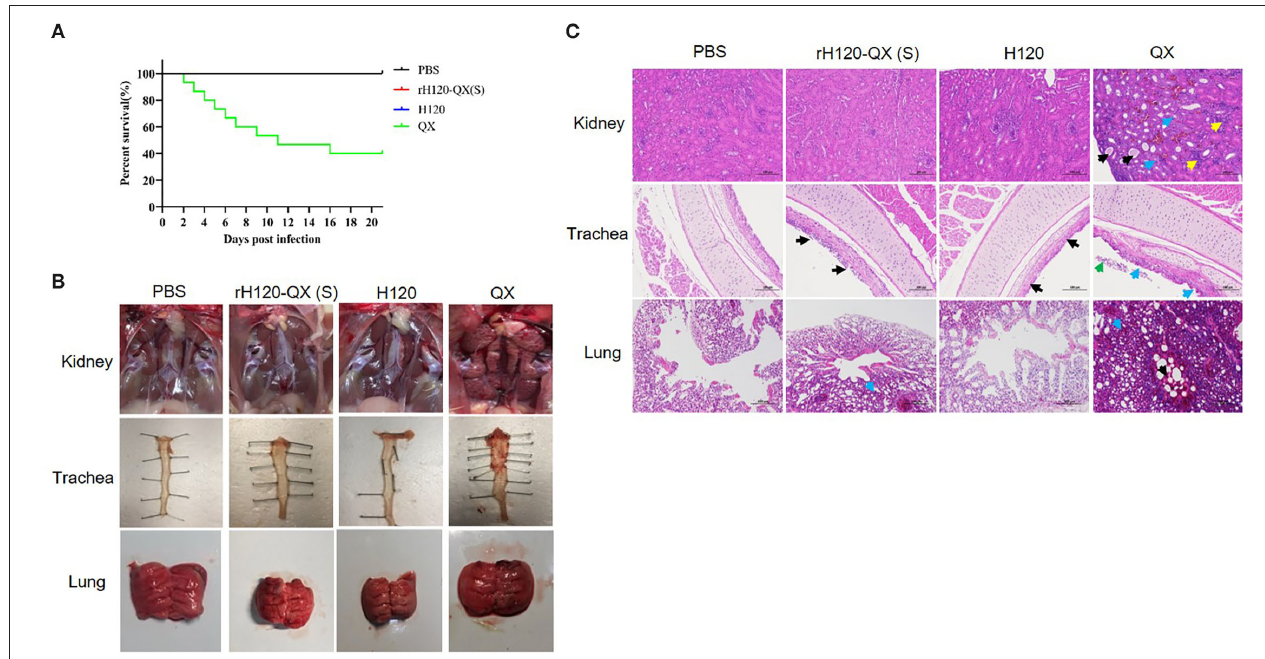
FIGURE 3 | The pathogenicity of rH120-QX(S), H120, and QX strains in 1-day-old SPF chickens. (A) Survival percentage of 1-day-old SPF chickens infected with rH120-QX(S), H120, or QX strains. The chicken’s death was observed during the period within 14 d.p.i. (B) Representative gross lesions on the trachea, kidney, and